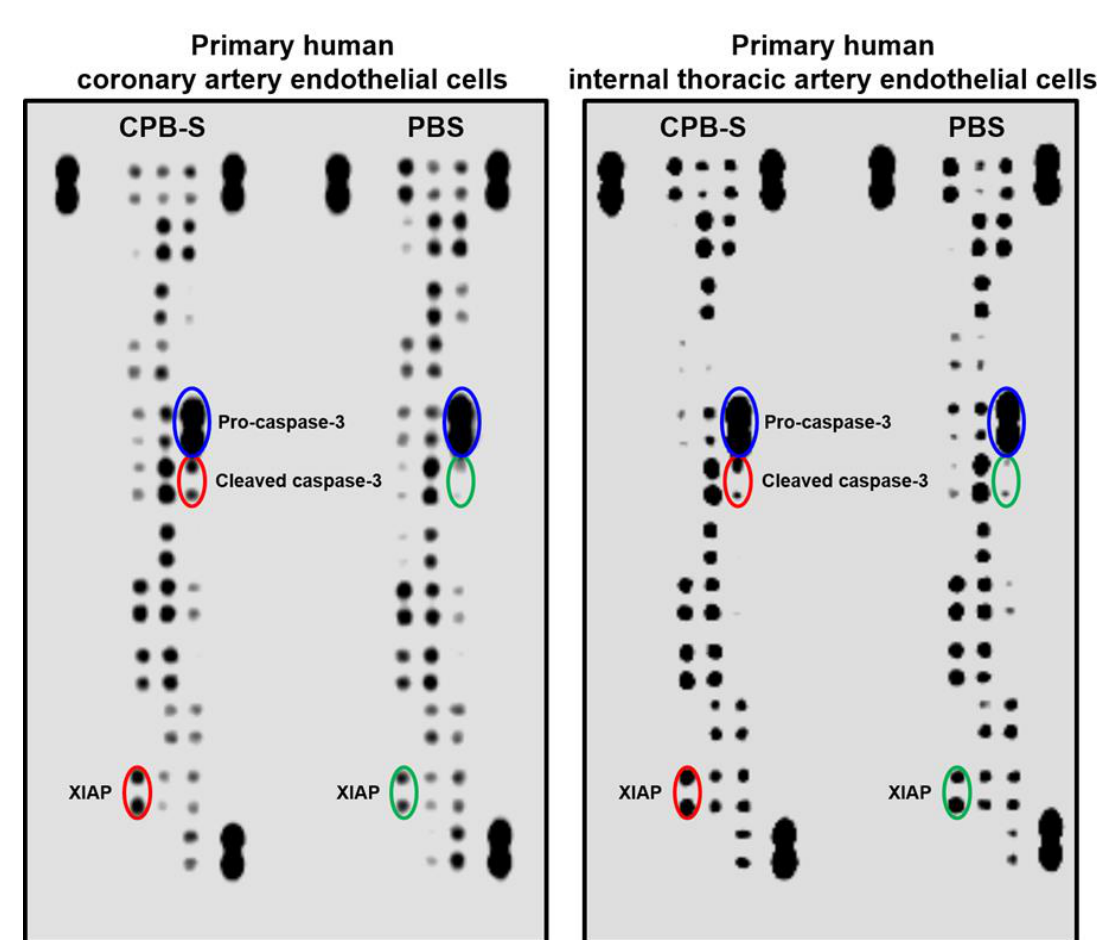
Figure 6. Proteomic profiling of apoptosis pathways in ( A ) HCAECs and ( B ) HITAECs upon exposure to CPB-S. Note the increase in cleaved caspase-3 in relation to procaspase-3 and the elevation of XIAP in both types of endothelial cells treated with CPB-S.